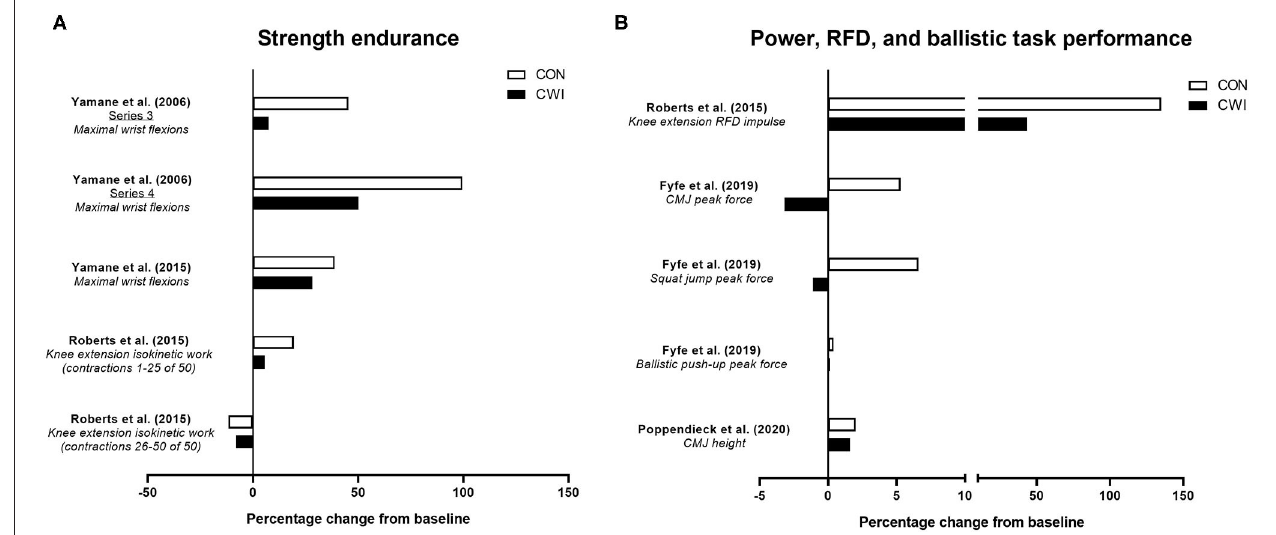
FIGURE 3 | Summary of studies investigating the effects of post-exercise cold water immersion (CWI) on changes in strength endurance (A) and measures related to power, rate of force development (RFD) or ballistic task performance (B) with resistance training. Effects are shown as mean percentage changes from baseline to